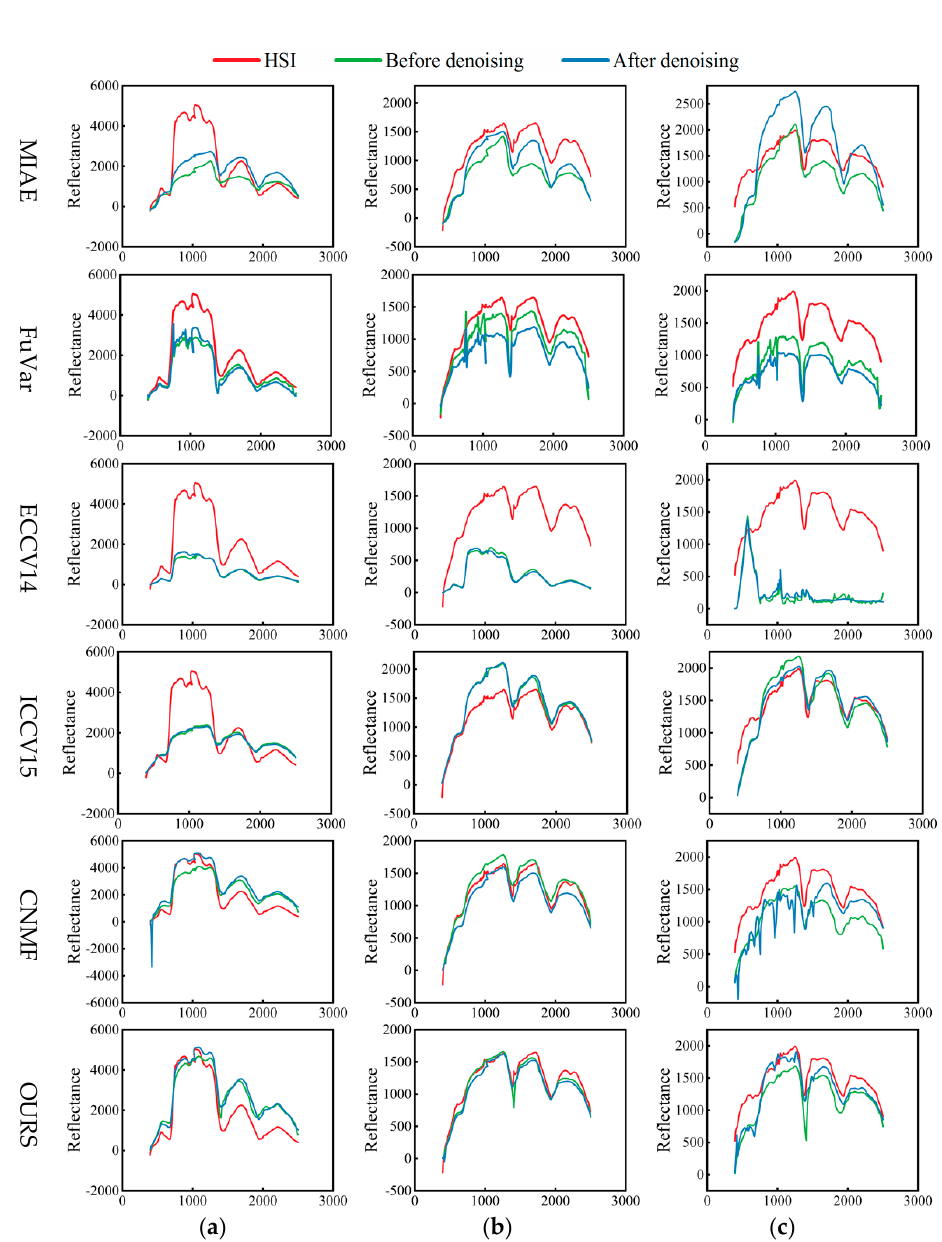
Figure 10. The spectral lines of SRR results in ZY − 1 02D HSI before and after denoising. From top to bottom, each row represents MIAE, FuVar, ECCV14, ICCV15, CNMF, and the proposed method. (( a ) column) vegetation; (( b ) column) soil; and (( c ) column) blue-roofed building.